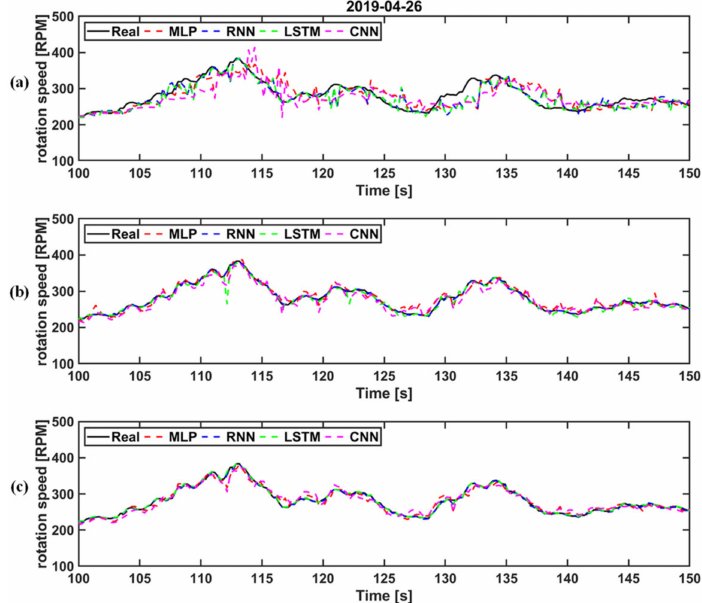
Figure 13. Comparison of amplified prediction performance as a function of the number of input datasets for each algorithm (26 April 2019): ( a ) the two datasets with the highest correlation; ( b ) six datasets with high correlation; and ( c ) all training